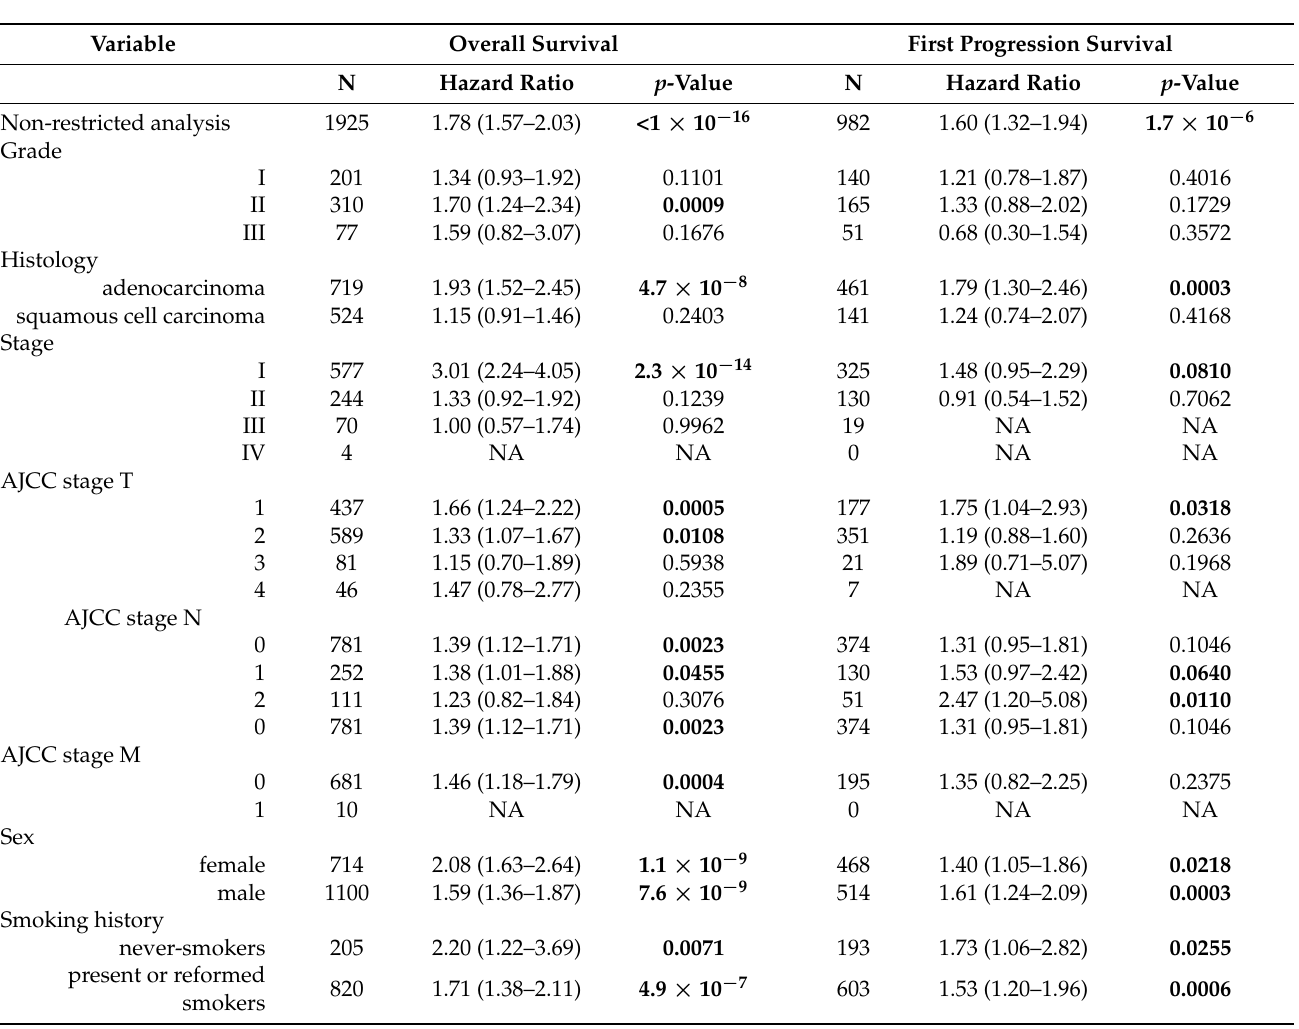
Table 1. Survival analysis of HMGA1 expression regarding selected clinicopathological factors in lung cancer by Kaplan–Meier